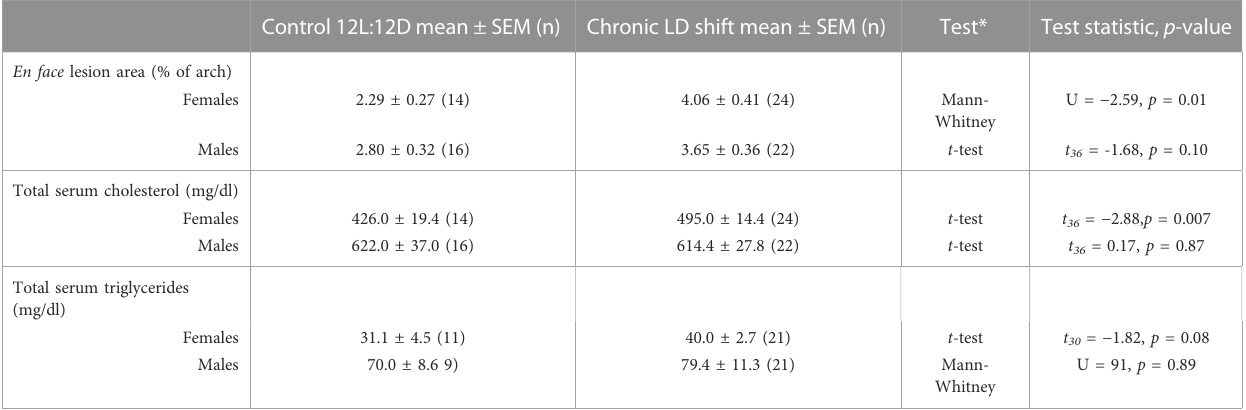
no signi fi cant differences in total serum cholesterol concentrations (Figure 2B; Table 1, t -test p = 0.87) or in the distribution of cholesterol on lipoproteins (Figure 2D) in male ApoE − / − mice